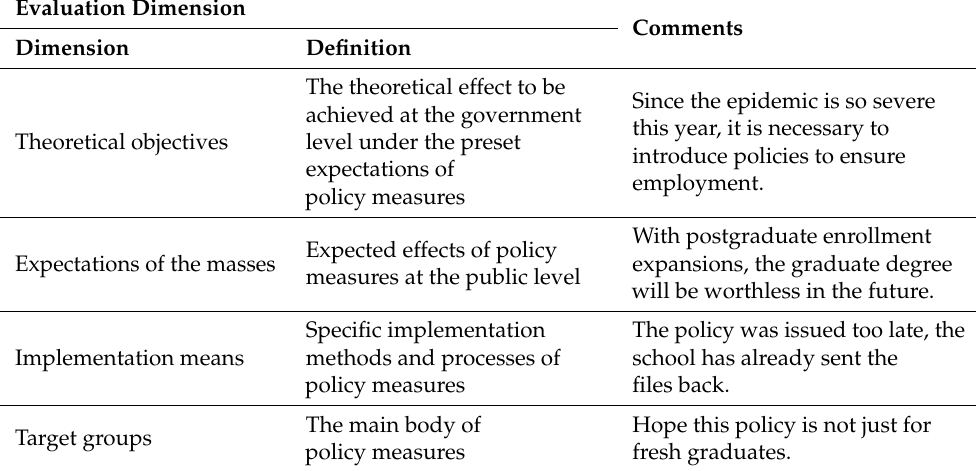
Table 7. Evaluation